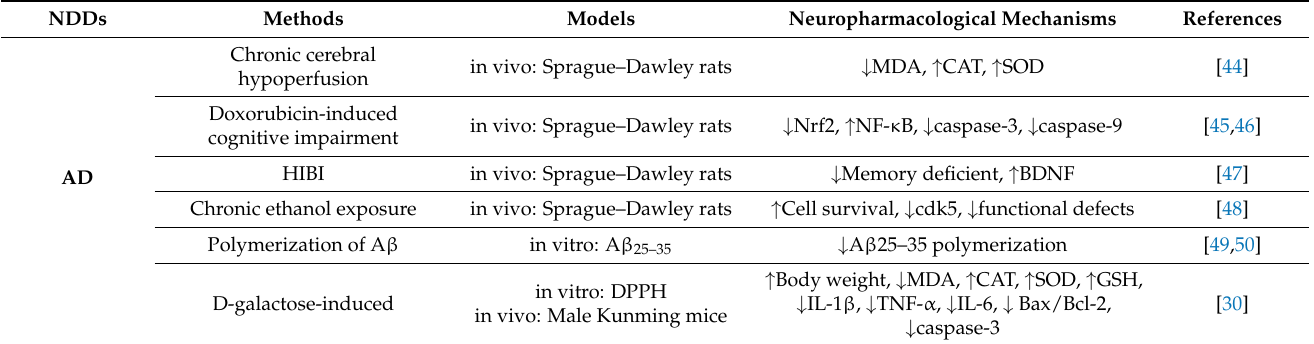
Table 1. Neuropharmacological mechanisms of polydatin against different